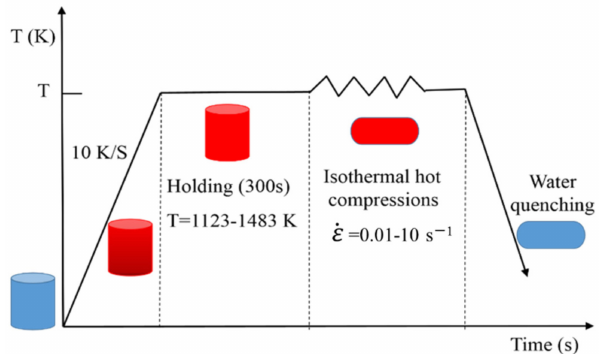
Figure 2. Schematic diagram of thermal compression tests.